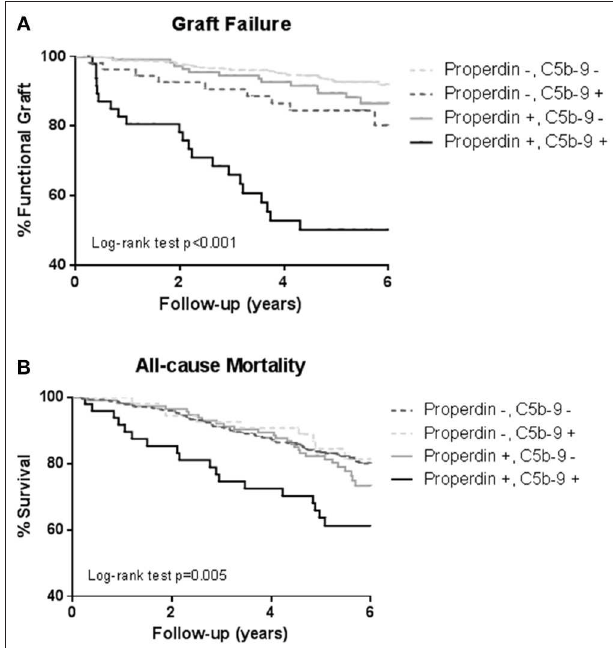
FIGURE 3 | Kaplan-Meier analyses for percentage graft failure (A) and survival (B) according to no sC5b-9/no properdin, sC5b-9/no properdin, no sC5b-9/properdin, sC5b-9/properdin. Log-rank tests showed that the prevalence of graft failure and survival were significantly higher in the patients with urinary properdin and sC5b-9. Associations between survival and urinary properdin and sC5b-9 did not remain significant after adjustment for potential